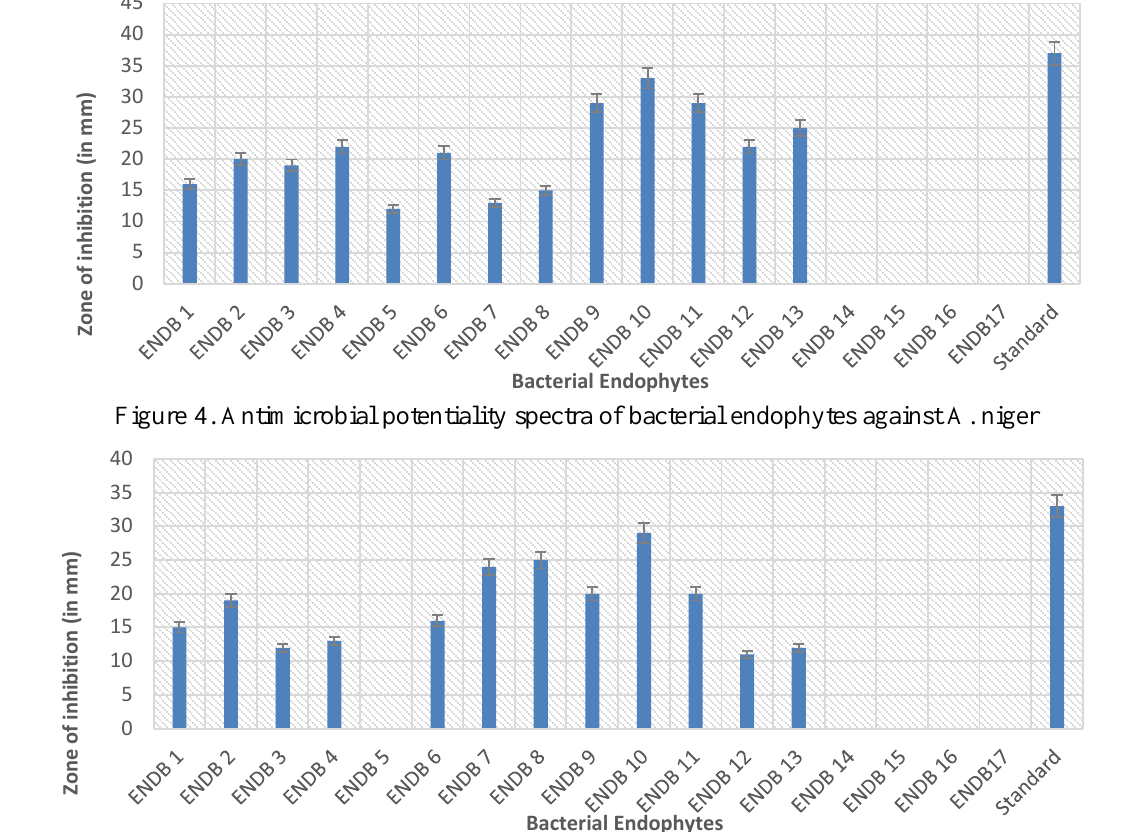
Figure 5. Antimicrobial potentiality spectra of bacterial endophytes against Fusarium oxysporum